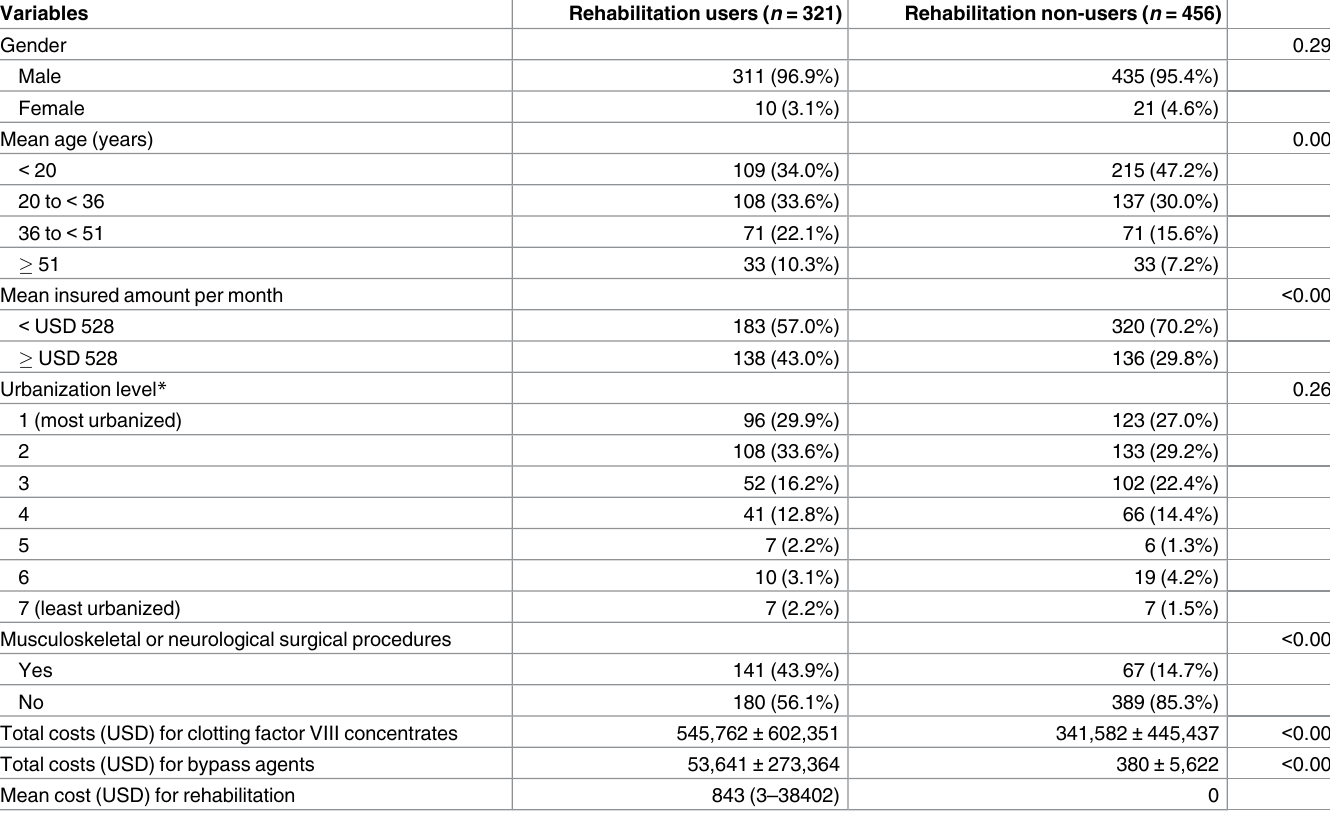
Table 1. Individual characteristics according to variables in patients with hemophilia A from 1998 to